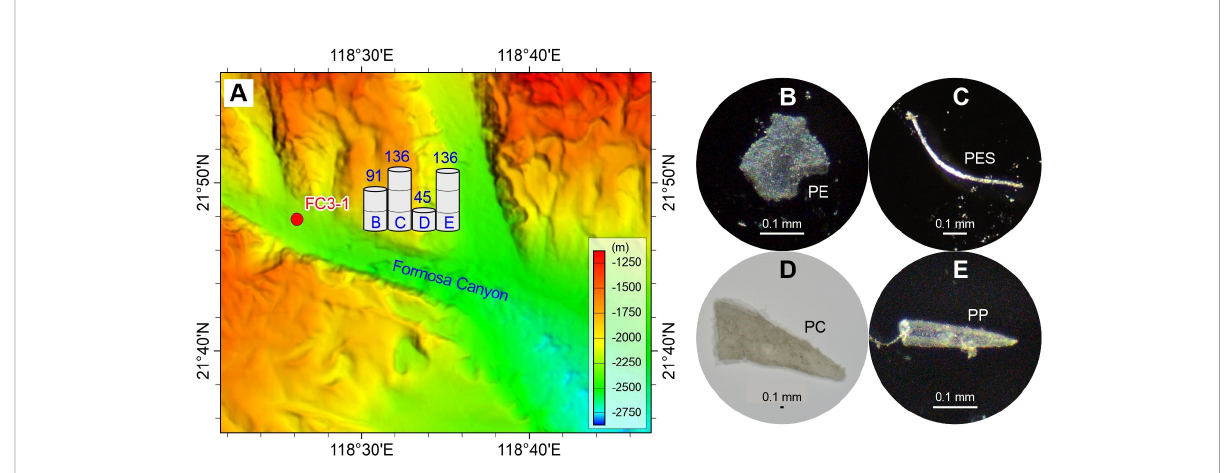
FIGURE 4 Abundance (A) and typical photographs (B – E) of microplastics in the surface sediment sample in the Formosa Canyon channel. The numbers above the histograms show the abundance (p·kg – 1 ) of microplastic compositions (panels B – E ). The detailed data are shown in Table 2. See Figure 1 for the location of sample FC3-1 and related Formosa